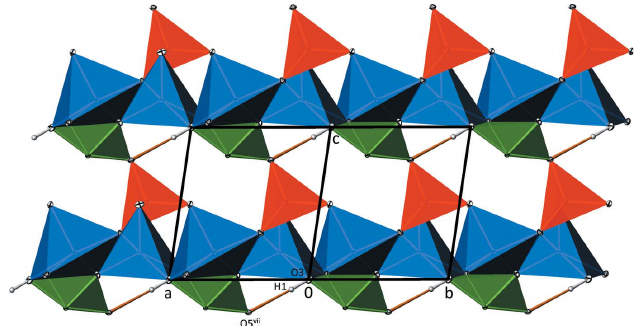
Figure 4 Channels in the crystal structure of Zn 2 (HTeO 3 )(AsO 4 ) running parallel